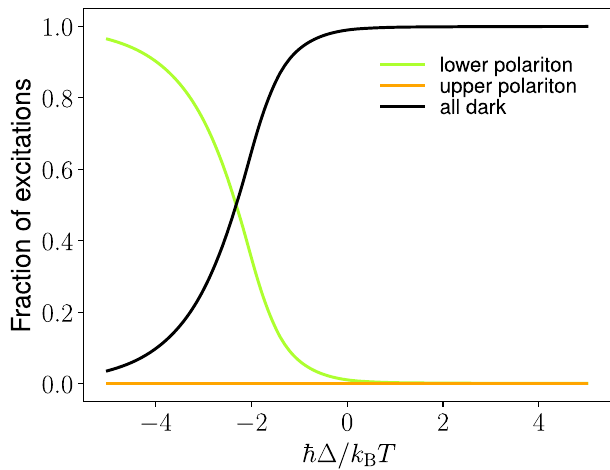
Fig. 2 Polariton condensation transition. Fraction of excitations in different modes as a function of cavity detuning ℏ Δ = ℏ ω ph − ℏ ω vib while keeping Fig. 3 Polariton condensation threshold. Numerically obtained average = N Γ the pumping rate P − fi xed. The black curve includes the excitations in all population per molecule at the condensation threshold (cid:2) n ¼ P # (10% th dark modes taken together while the green and orange curves show the of the excitations are in the lower polariton), for a range of light-matter ffiffiffiffi p fraction excitations in the lower and upper polariton, respectively. The coupling strengths 2 _ g N and cavity detunings ℏ Δ = ℏ ω ph − ℏ ω vib . In the ffiffiffiffi p = k condensation transition takes place close to ℏ Δ ≈ − 1.5 k B T . Here, the lower black and purple regions of the plot ( Δ > 0 and 2 _ g N B T < 2), the polariton is pumped with rate P − = 0.16 N Γ ↓ , the light-matter coupling threshold for condensation is high, (cid:2) n (cid:3) 1, and polariton condensation is ffiffiffiffi p ¼ 0 : 72 k = 0.1389 ℏ ω = 298 K when 2 _ g N dif fi cult to achieve experimentally. The threshold for condensation is much vib ( T B T , the temperature k B T ℏ ω = 185 meV), number of molecules N = 10 7 and cavity leakage rate lower, (cid:2) n < 0 : 1, for the lighter colored (yellow, orange) regions. In our plot vib κ = Γ above only the upper polariton is pumped and we use cavity leakage rate ↓ . ffiffiffiffi p κ = Γ ↓ . The vertical lines correspond to 2 _ g = k N ffiffiffiffi p ffiffiffiffi p B T at room temperature (cid:4) 700cm (cid:2) 1 ) and W(CO) _ g (cid:4) 50cm (cid:2) 1 ). for H 2 O (2 _ g N N 6 (2 Calculations in Figs. 4 – 6 are presented for the conditions in point